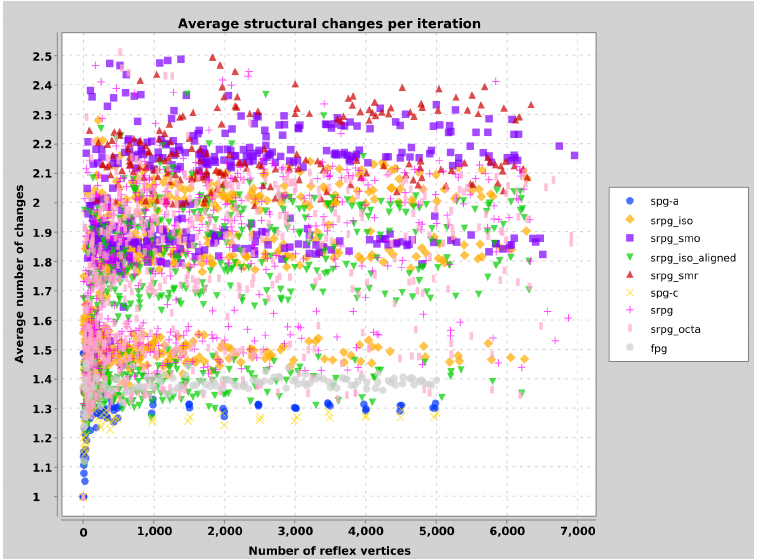
Figure 12. Average number of structural changes per insertion step. (For polygons from [10] with up to 7000 reflex vertices).